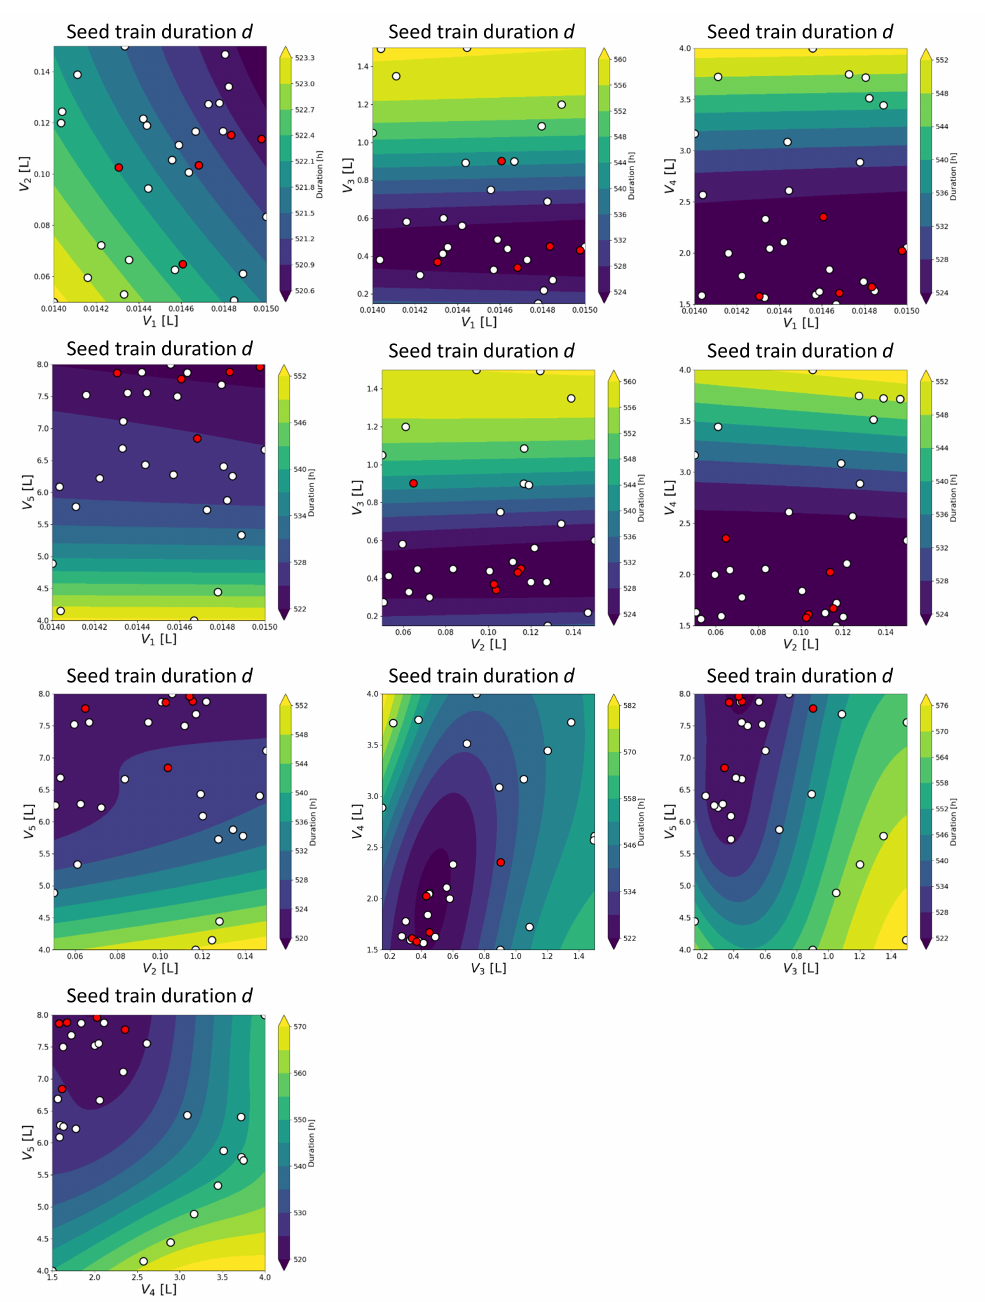
Figure 5. Contour plots showing two optimizable variables on x and y-axis and one objective (here seed train duration ( d ) in h), assigned to each combination of the two variables, through colored isolines. For example, the diagram top left shows the deviation rate for each combination of V 1 (filling volume in flask scale 1) and V 2 (filling volume in flask scale 2) through colors representing the corresponding values in %, as indicated on the color bar. Moreover, the results obtained through seed train simulations are shown by dots. The red dots represent the non-dominated (optimal